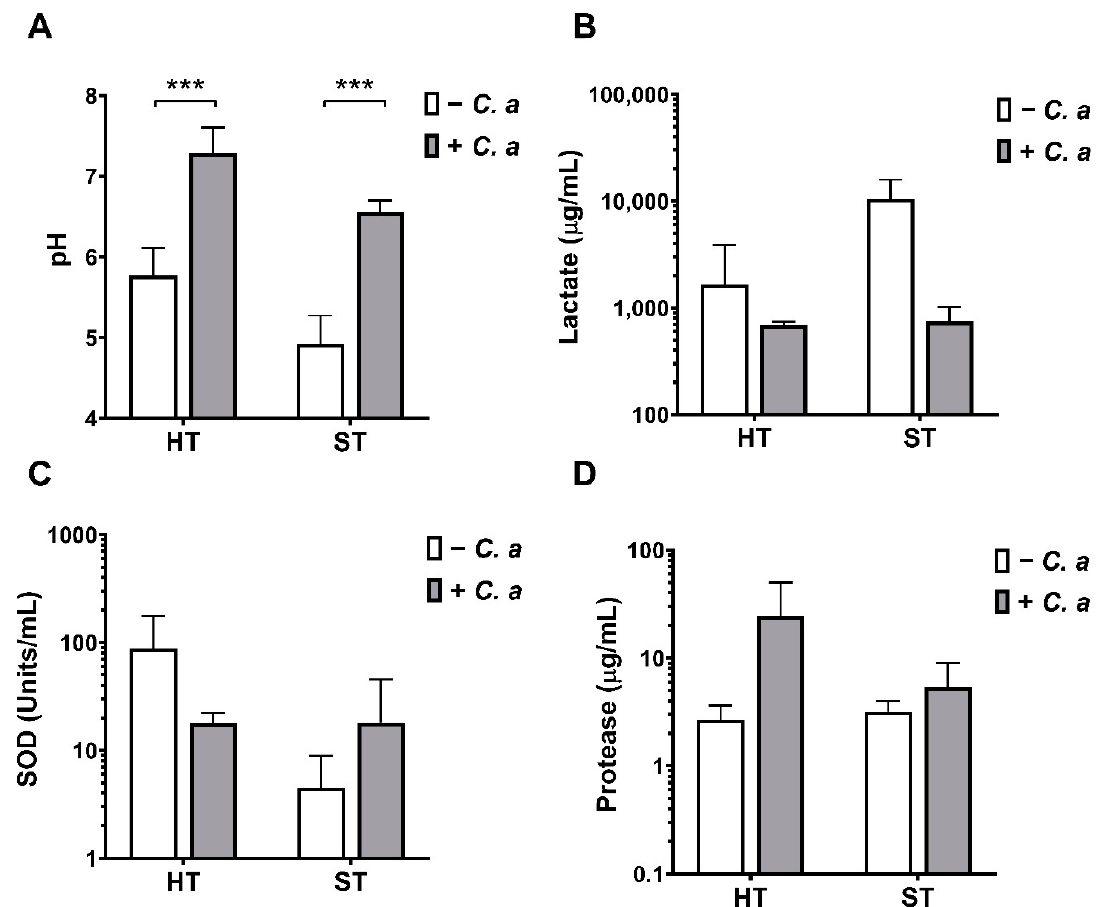
Figure 4. Assessment of functional biomarkers in hard tissue (HT) and soft tissue (ST) biofilms with or without C. albicans . Supernatants were collected on the final day of maturation and stored at − 80° C until required. Prior to freezing, pH was tested using a microprobe ( A ). Lactate assay kit was used to determine lactate content ( B ). Superoxide dismutase assay was carried out using WST-1 tetrazolium salt and xanthine as per assay instructions with a 100 × sample dilution applied ( C ). Protease activity was assessed using a fluorescent protease detection kit. Trypsin was used as a standard curve as per manufacturer’s instructions ( D ). Data represented as mean ± SD, sampled in triplicate from three independent experiments. A Mann–Whitney t-test was used throughout to assess significant differences between the means of models with or without C. albicans (*** p <